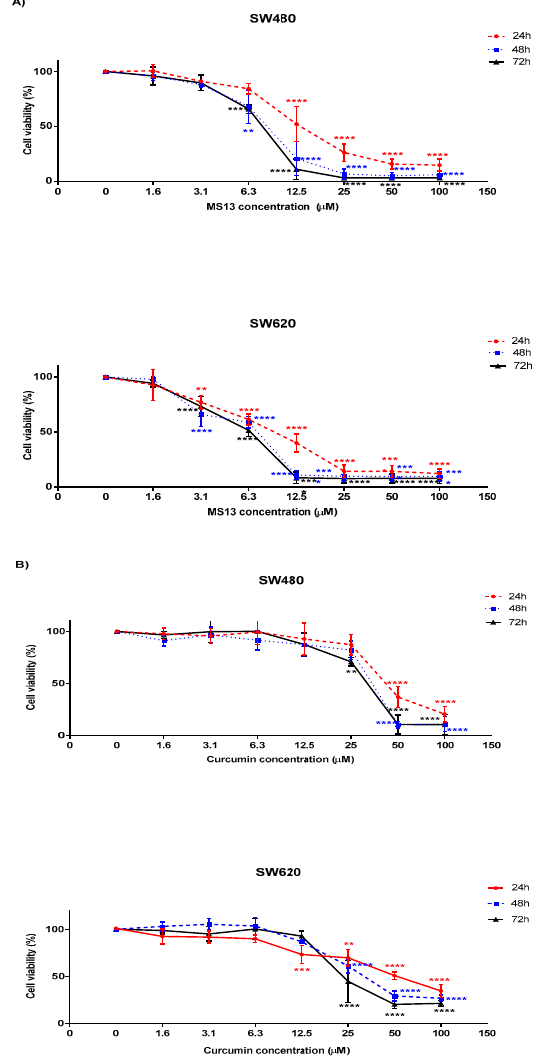
Figure 4. The anti-proliferative effects of ( A ) MS13 and ( B ) curcumin on SW480 and SW620 at 24, 48 and 72 h. Experiments were performed in triplicates and results were compared between three independent experiments. Asterisk indicates statistically significant (* for p ≤ 0.05, ** for p ≤ 0.01, *** for p ≤ 0.001 and **** for p ≤ 0.0001) differences between the means of values with treated vs untreated cells. Error bars indicate mean ± SEM.